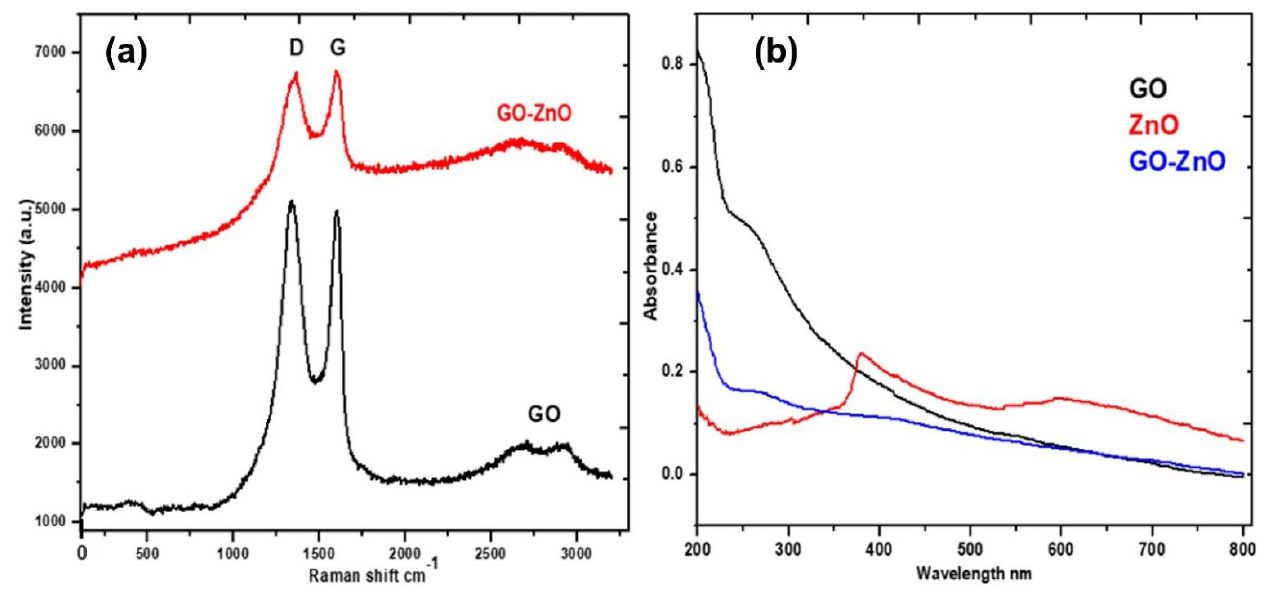
Figure 5. ( a ) Raman spectra of GO and GO-ZnO, ( b ) UV-vis spectra of GO, ZnO and GO-ZnO as-prepared.